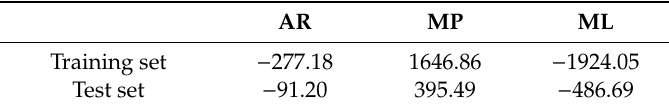
Table 4. Comparison of the values of indicators for the training set and the test set.